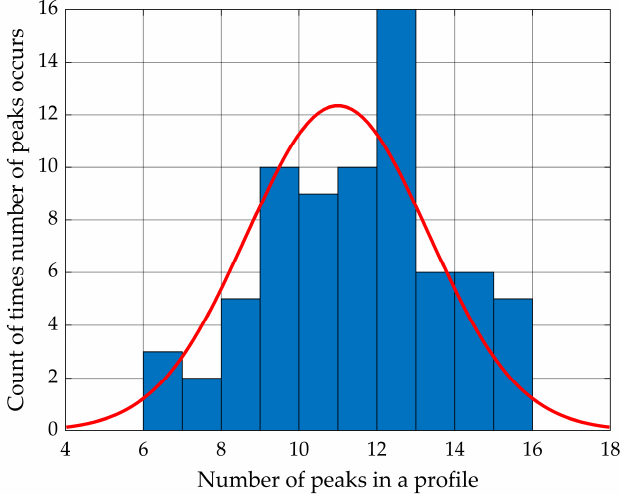
Figure 10. The probability distribution of the number of peaks in a profile (blue bars) and the Gaussian fit to that distribution (red line) from Transect 3, Pass 6.